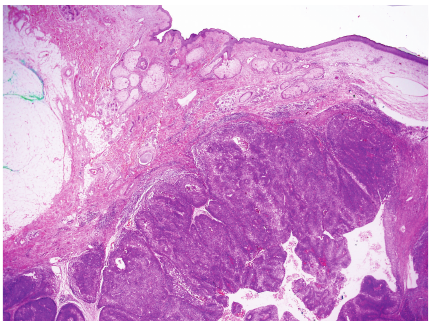
Figure 24: Metastatic SCC: low-power magnification showing solid growth of SCC which is predominantly located in the dermis and subcutaneous tissue. The overlying epidermis appears normal. This should raise suspicion of a metastatic deposit. (H&E, × 40).